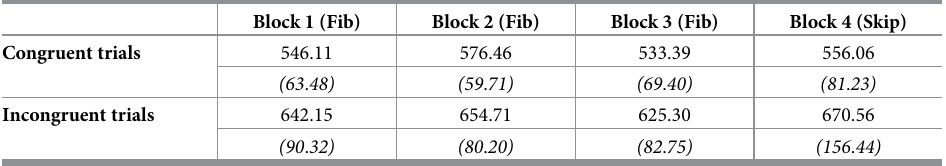
Table 3. Mean ( Standard Deviation ) reaction times for congruent and incongruent trials in each block (Analysis